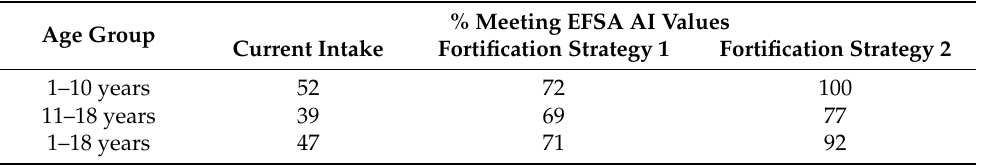
Table 3. Projected impact of strategy 1, the fortification of dairy alternative milk only, and strategy 2, the fortification of dairy alternative milk, yoghurts, custards/desserts and cheeses with iodine to levels described in methods based on current levels of consumption ( µ g/day) on meeting EFSA AI